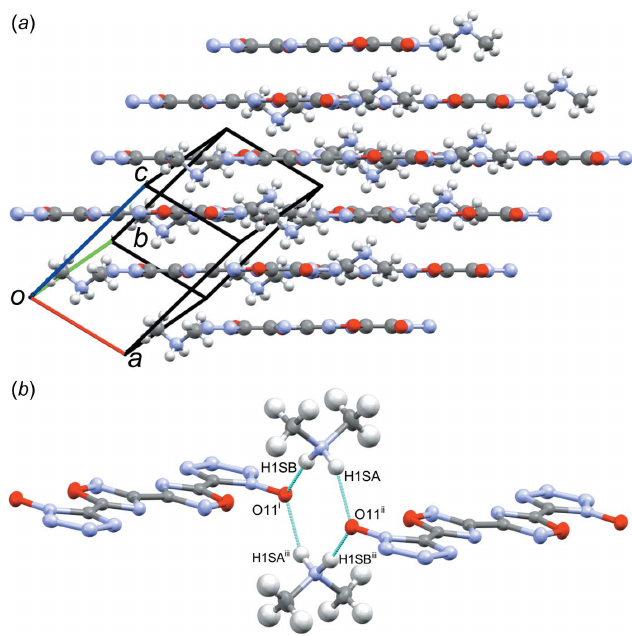
Figure 8 ( a ) Sheet-like packing of 3 as viewed approximately perpendicular to the (0 21) plane, showing the layers of dianion and associated dimethyl- ammonium cations, and ( b ) view highlighting the hydrogen-boning network (intermolecular contacts) between dimethylammonium cations and the dianions. [Symmetry codes: (i) x , y , z (cid:3) 1; (ii) (cid:3) x + 1, (cid:3) y , (cid:3) z + 1; , z + 1 ; 2 2 (iii) 1 (cid:3) x , (cid:3) y , (cid:3) z .]